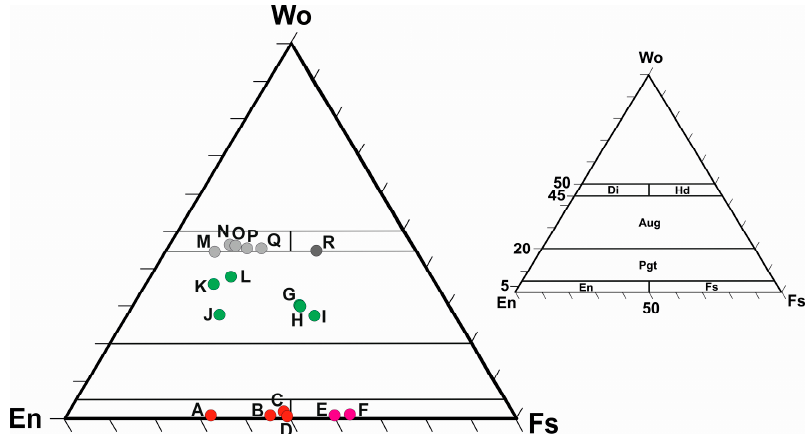
Figure 16. Classification diagram for identified pyroxenes in samples collected from the Northern Portuguese continental shelf by combining the classification diagrams of clinopyroxenes and orthopyroxenes proposed by [48]. The classification shows the presence of diopside (Di), hedenbergite (Hd), augite (Aug), enstatite (En), and ferrosilite (Fs). Pigeonite (Pgt) was not found. A–D are En mineral grains from sample P20; E and F are Fs mineral grains from sample P20; G–I are Aug mineral grains from sample P6; J and K are Aug mineral grains from sample P17; L is a Aug mineral grain from sample P20. The location of the samples can be seen on Figure 11.